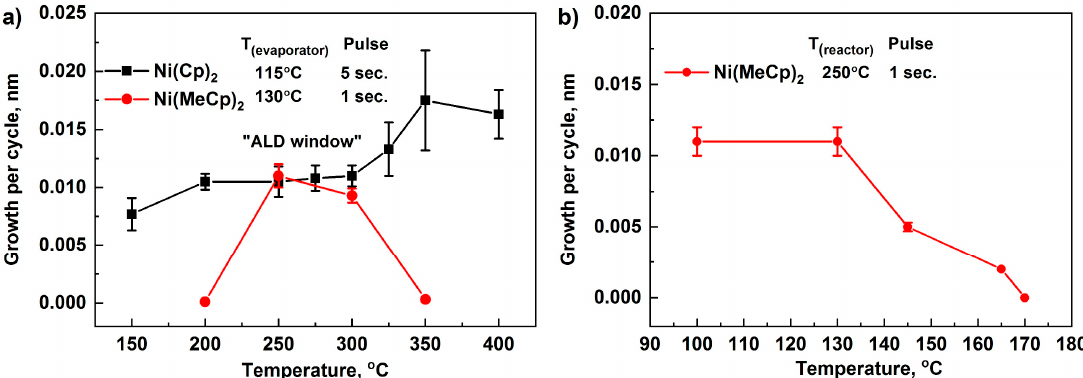
Figure 2. GPC as a function of the deposition temperature for NiCp 2 , Ni(MeCp) 2 , and O 2 plasma ( a ) and GPC as a function of the Ni(MeCp) 2 container temperature ( b ). Error bars indicate the thickness gradient.